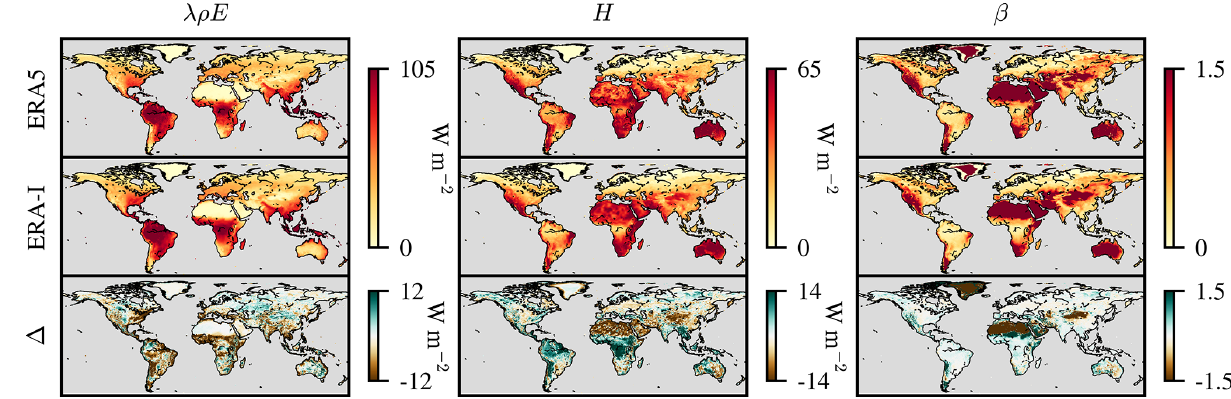
Figure 11. Maps of the multi-annual average of surface latent heat flux ( λρE , Wm − 2 ), surface sensible heat flux ( H , Wm − 2 ), and Bowen ratio ( β ) from ERA5 and ERA-I. In the last row, (cid:49) presents the difference between ERA5 and ERA-I; hence, green colours represent higher values in ERA5 compared to